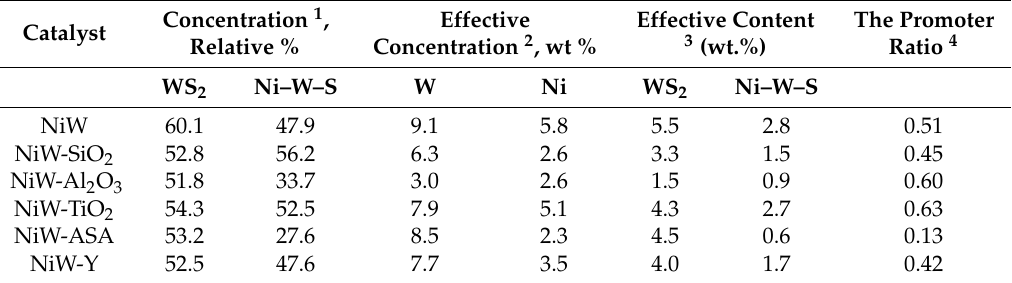
Table 2. Results of the surface analysis of the catalysts.